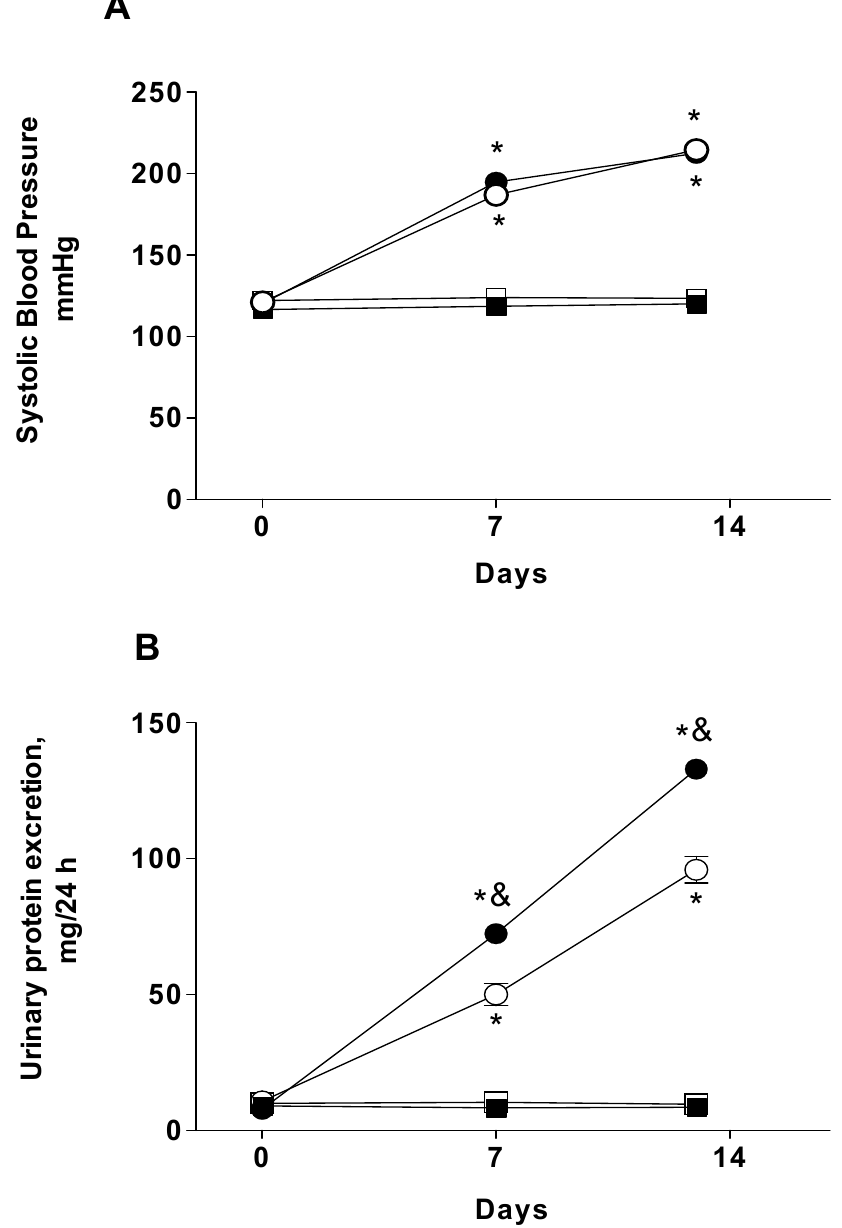
Figure 1. Systolic blood pressure ( A ) and urinary protein excretion ( B ) in Sham-operated, Sham + BBG, Ang II, and Ang II + BBG groups. Black squares (cid:4) Sham; open squares (cid:3) Sham + BBG; black circles • Ang II; open circles Ang II + BBG; n = 8 rats / group. * p < 0.001 vs. Sham; & p < 0.05 vs. Ang II + BBG. Ang II = angiotensin II, BBG = Brilliant blue G.